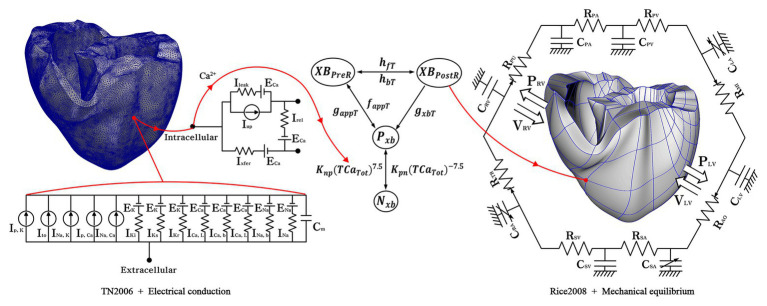
Schematic of the electromechanical model with implementation of one-way coupling in the cardiac excitation-contraction mechanism. The left side of the circuit diagram depicts a human electrophysiological ventricular model, which consists of 619,360 nodes and 3,439,590 tetrahedron elements. The electrical components of the schematic represent the current, pump, and ion exchanger from Ten Tusscher et al. (2009), which emulate the cell membrane for ion transport and the sarcoplasmic reticulum within cardiac cells. “I” is the ion currents, and “E” is the equilibrium potential of each ion; the right side depicts a human mechanical ventricular model, which is consists of 14,720 nodes and 6,210 hexahedron elements. The mechanical components represent excitation-contraction mechanism through cross-bridge of myofilaments from Rice et al. (2008) Conformations of a regulatory protein represent as non-permissive (Nxb) and permissive (Pxb), and the state of the myosin is denoted as XBPreR of the pro-rotated state and XBPostR of post-rotated state. gxbT, hfT, and hbT are the rate of the ATP-consuming detachment transition, the forward transition and, the backward transition, respectively. faapT refers to the cross-bridge attachment rate of the changeover to the first strongly bound state, and gaapT refers to its reverse rate. Knp and Kpn denote transition rates; Knp(TCaTot)7.5 and Kpn(TCaTot)−7.5 are the transition rates of the nonpermissive to permissive (forward) and the permissive to non-permissive (backward), respectively. The mechanical model is combined with the circulatory model using the coupling method suggested by Gurev et al. (2011) “R” and “C” are the resistance and compliance of the cardiac circulatory system, respectively (For more details, see the text).